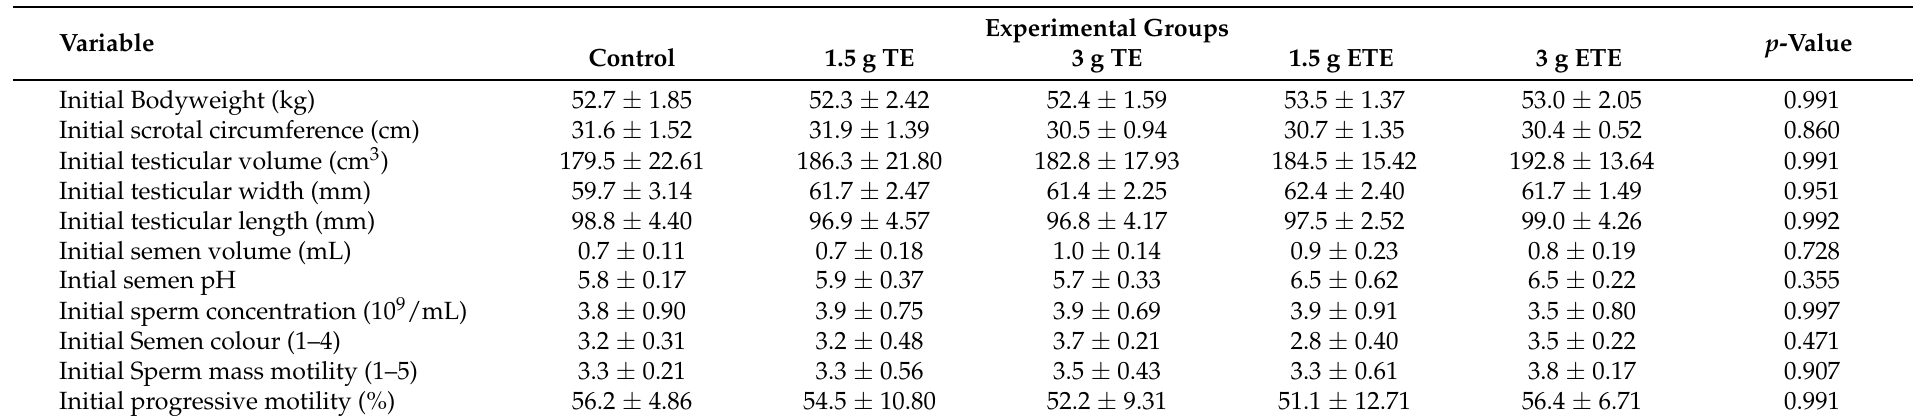
Table A1. The initial data of the experimental groups (Mean ± SE) in the